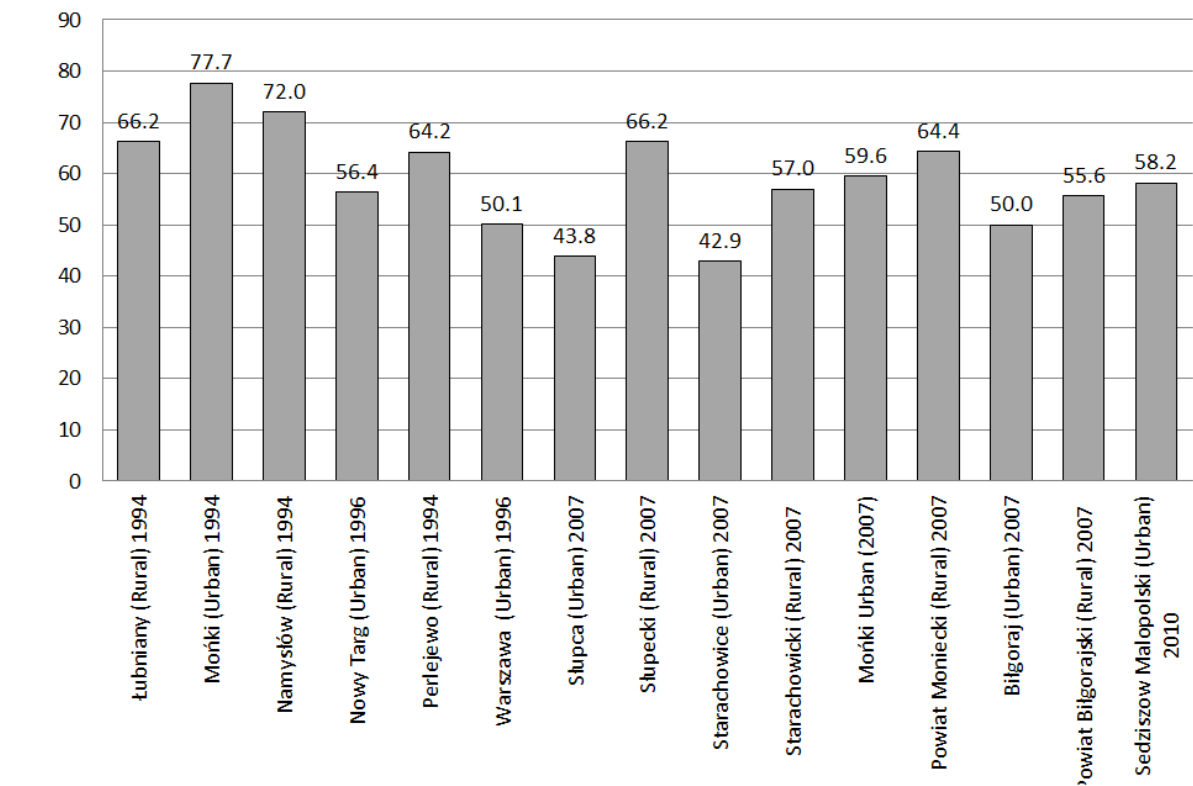
Figure 2. Response rates for ethnosurveys completed in Poland,